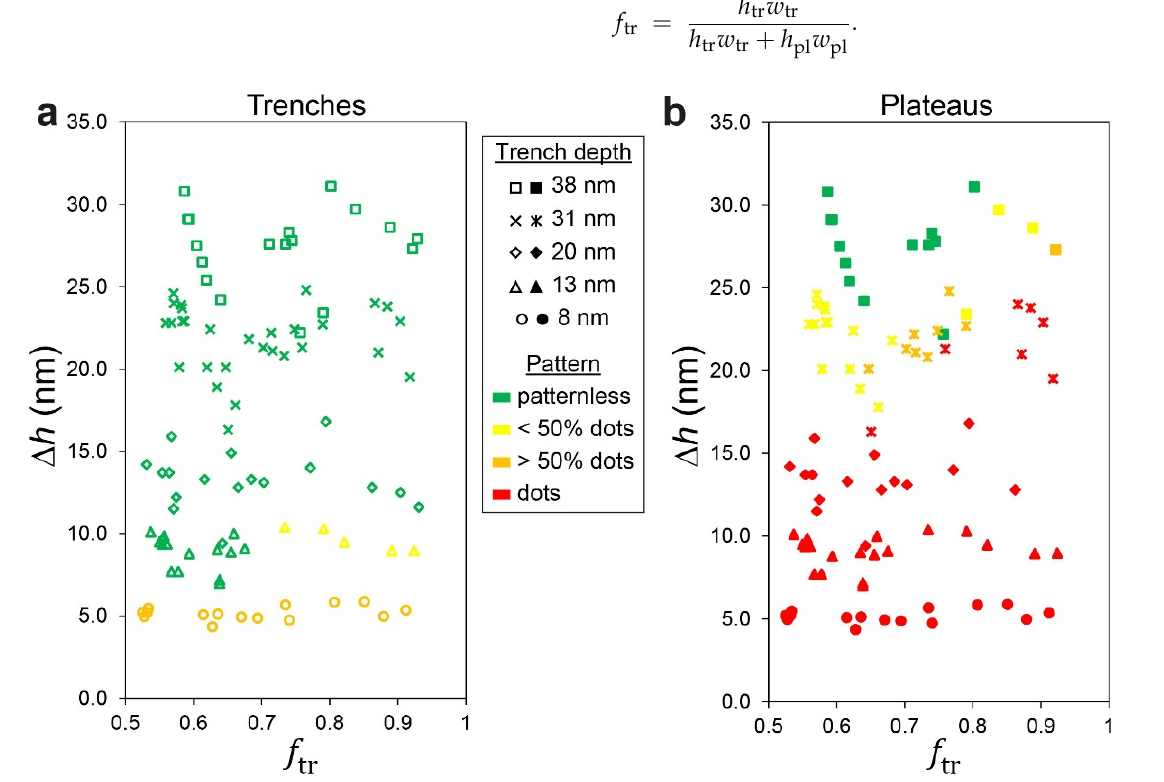
Figure 9. Phase diagrams of the morphologies of lamellar PS- b -PMMA cast over topographically patterned substrates for a constant nominal film thickness of 22–23 nm: ( a ) patterns that develop in the trenches; ( b ) patterns that develop on the plateaus.